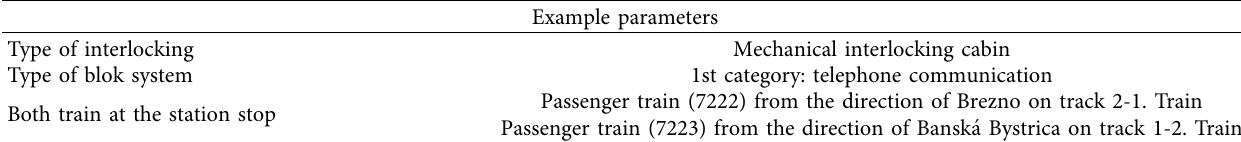
Table 5: Input data necessary for the calculation of the interval of crossing.